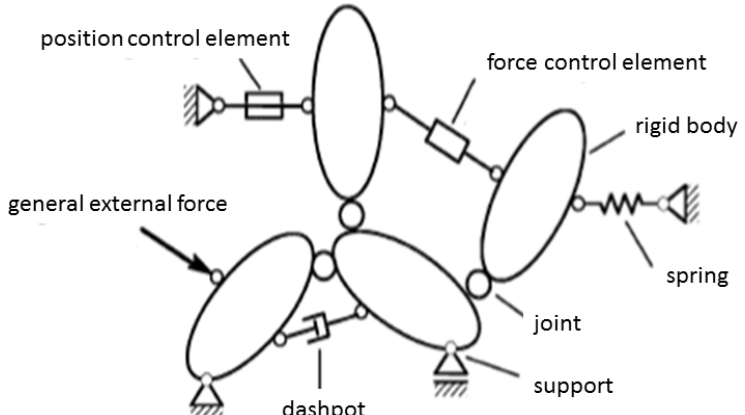
Figure 3. General Multi-body System (MBS) with components (Reprinted with permission from [10]. Copyright 2013